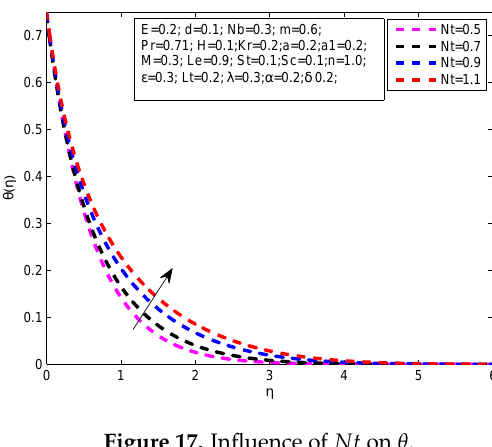
Figure 17. Influence of Nt on θ .